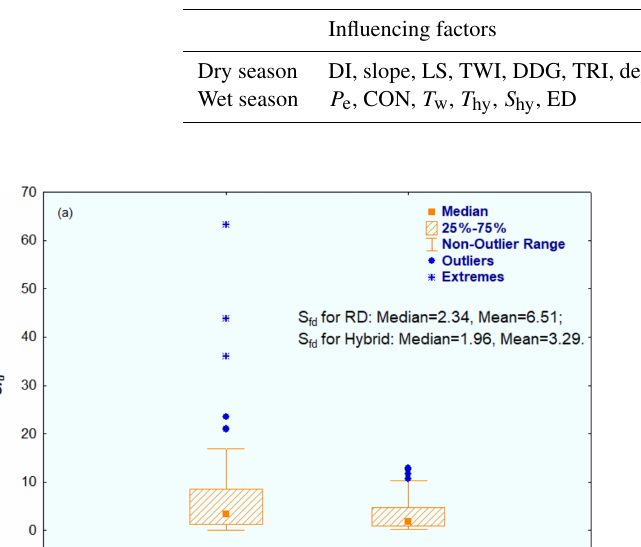
Table 7. Selected factor analysis models.